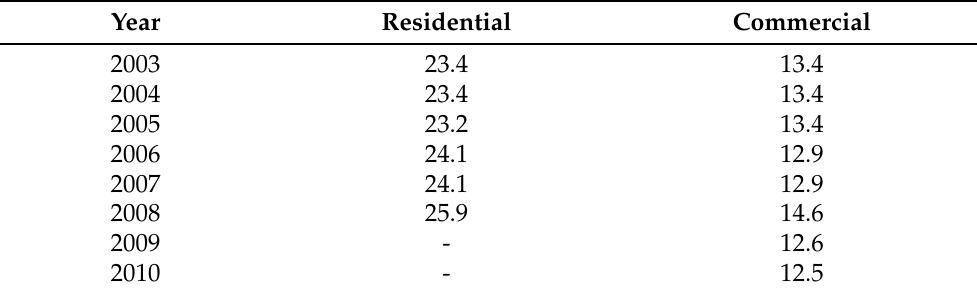
Table 2. Residential and commercial solar PV surplus purchase price (JPY/kWh)